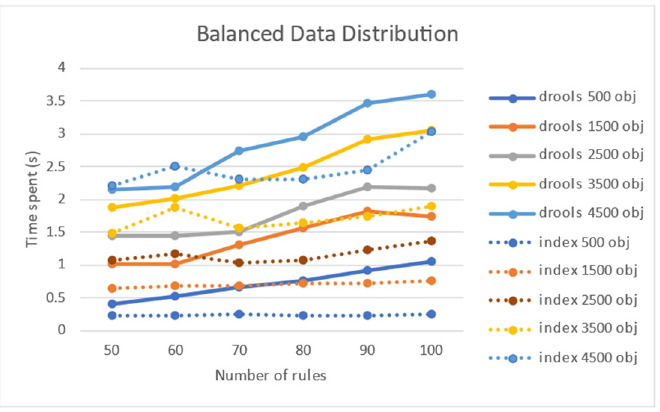
Figure 13. Performance comparison with Drool according to the number of rules. When the target objects were evenly distributed in the performance comparison experiment with Drool, the performance effect of the number of rules was lower than the effect of the number of target objects. As can be observed in Figure 14, when the number of target objects is 4500 for 100 rules, Drool exceeds 3.5 s, and the node index method requires more than 3 s. Based on the experimental results, the increase in the number of rules had an insignificant effect on performance. This may be attributed to the non-